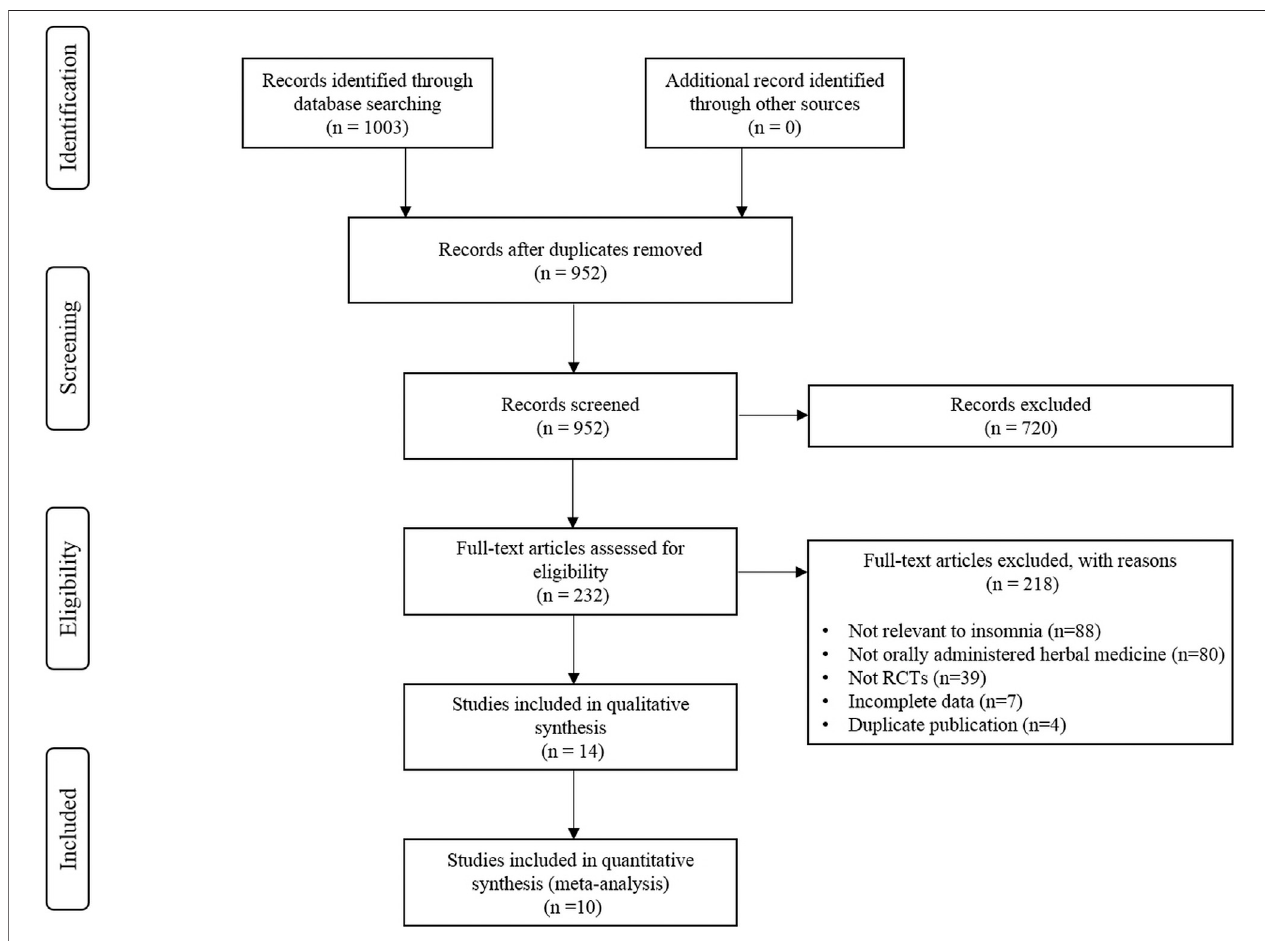
FIGURE 1 | PRISMA fl owchart of study